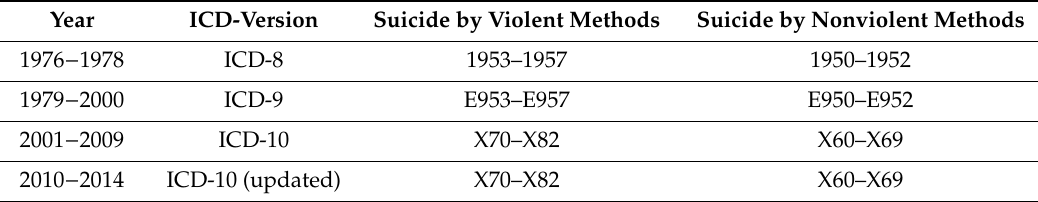
Table 1. International Classification of Diseases (ICD) used for identification of suicide